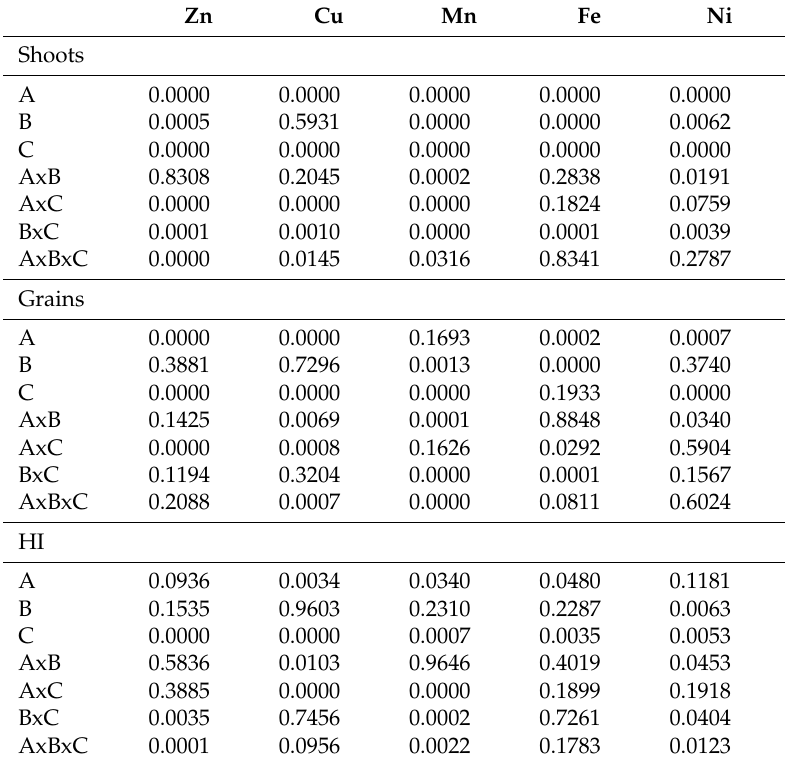
Table 2. ANOVA: empirical significance level p for studied: Zn, Cu, Mn, Fe and Ni